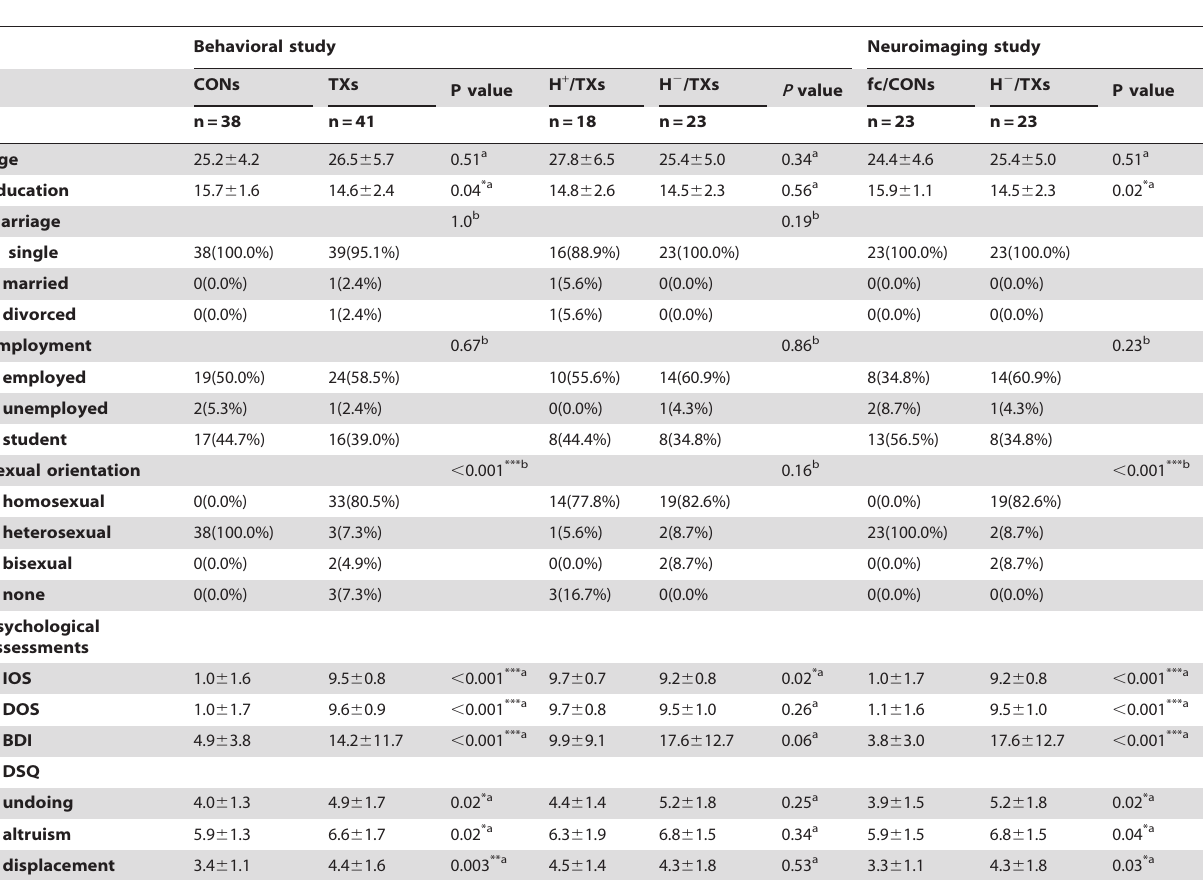
Table 2. Demographic data and the results of psychological